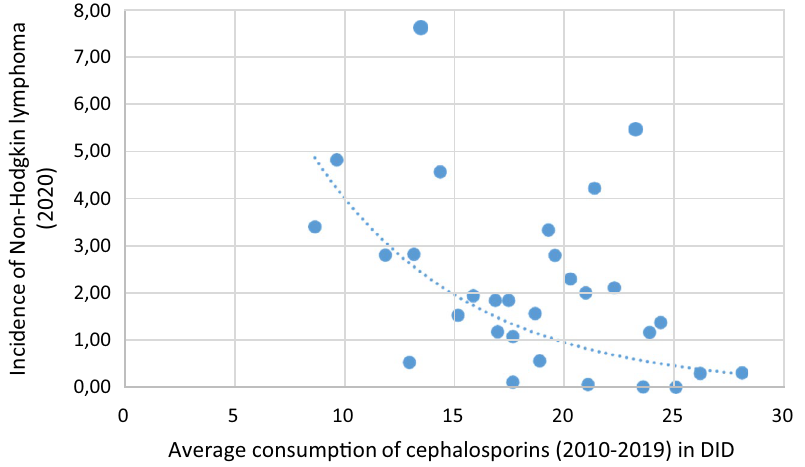
Figure 4. A significant negative association was found between cephalosporin consumption and the incidence of NHL